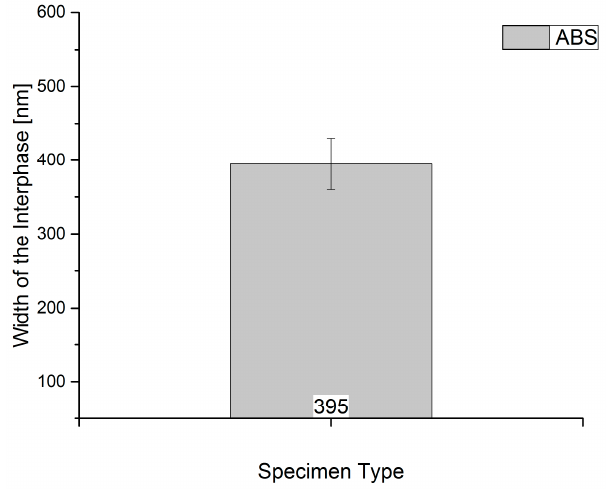
Figure 6. Interphase width for the influence of the amorphous material measured with the introduced nano-scratch method.